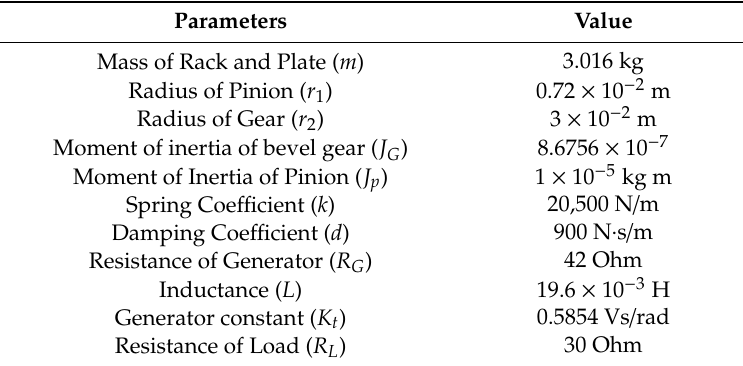
Table 1. Rack-Pinion Parameters.